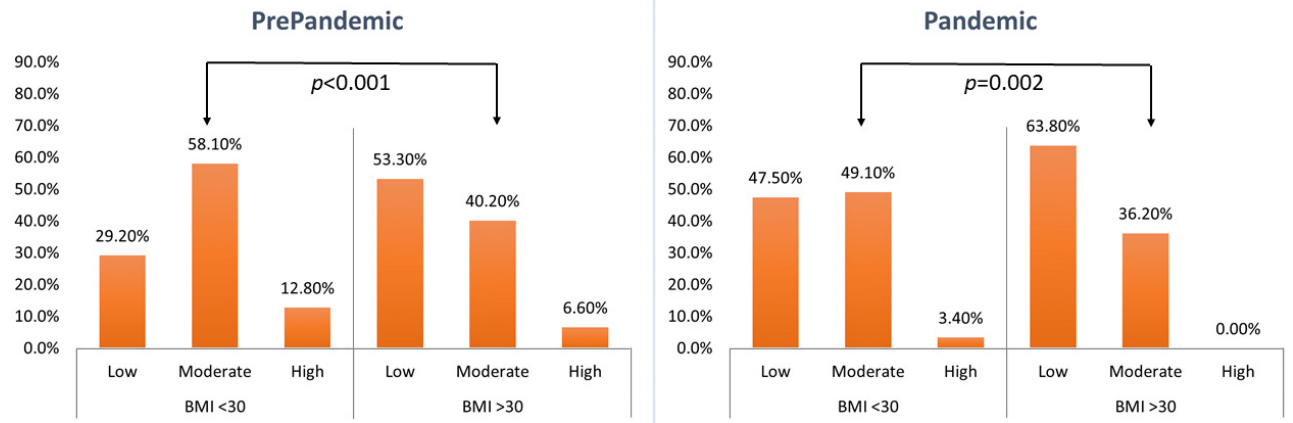
Figure 3. Assessment of physical activity during leisure time (Mann–Whitney–Wilcoxon test). Table 6. Assessment of physical activity at work or school.